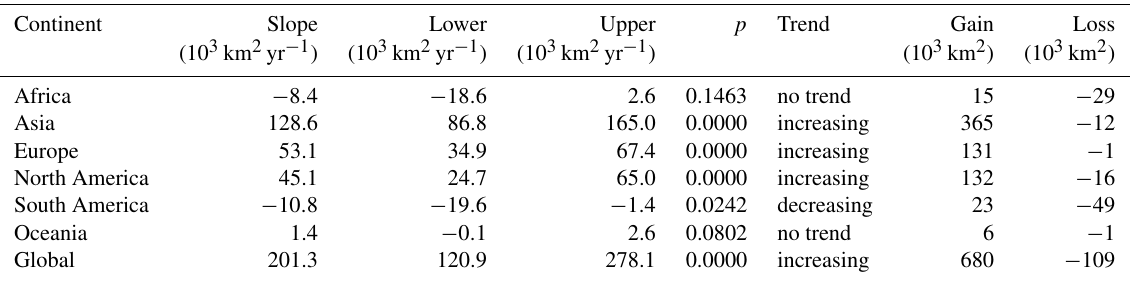
Figure 9. Area curves of global annual land cover change from 1982 to 2015. Table 10. Statistical results of change analysis for forest (on the scale of continents). Annual change slope and its 95% confidence interval are given by Theil–Sen estimator, p value, and trend information from a Mann–Kendall test. Gain and loss areas are summarized results relating to the whole time